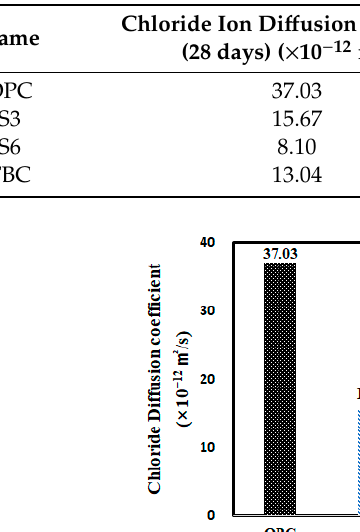
Table 6. Result of chloride ion diffusion of concrete.